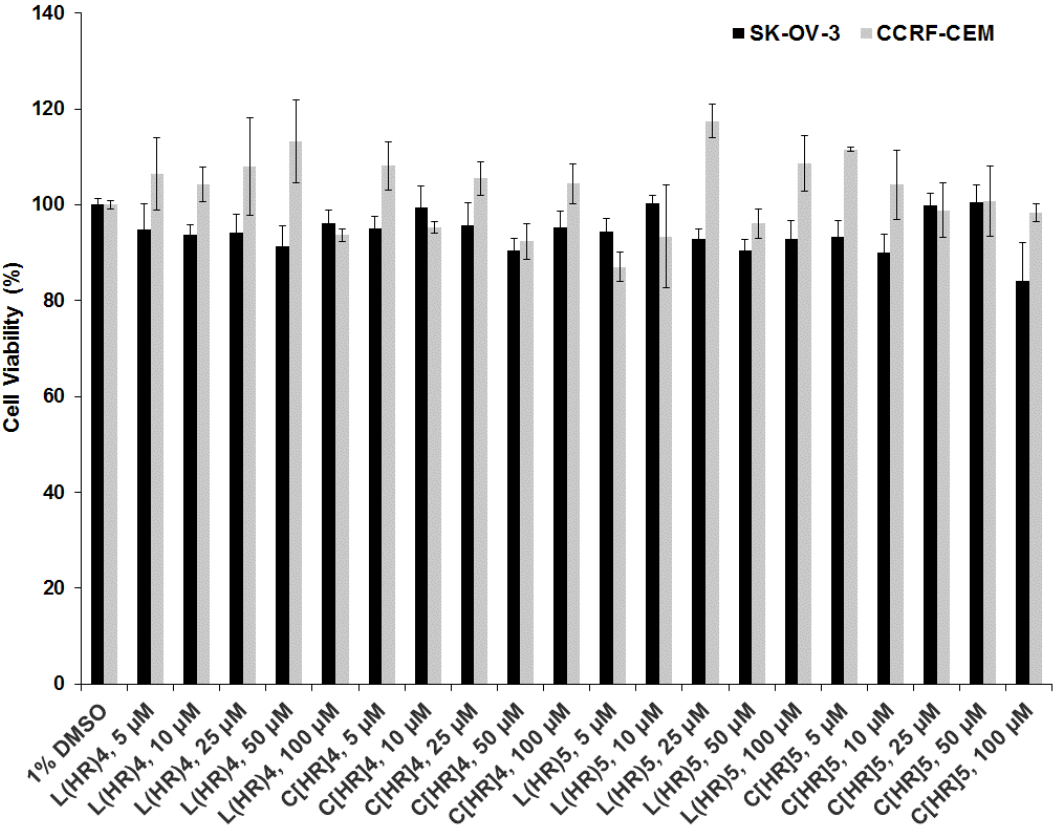
Figure 2. Cytotoxicity study for l(HR) 4 , l(HR) 5 , c[HR] 4 , and c[HR] 5 at 5, 10, 25, 50, and 100 µM in SK-OV-3 and CCRF-CEM cell lines after 24 h incubation.